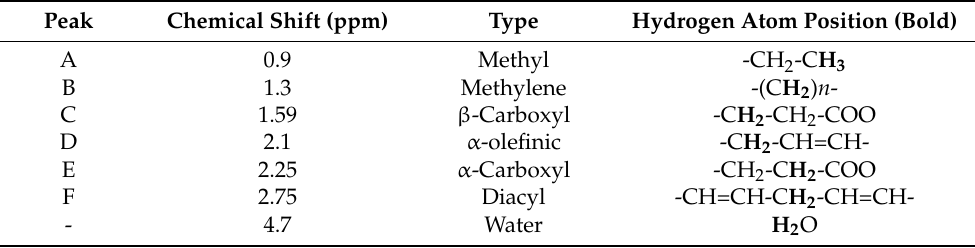
Table 2. Detectable metabolite peaks from the liver MR spectrum.